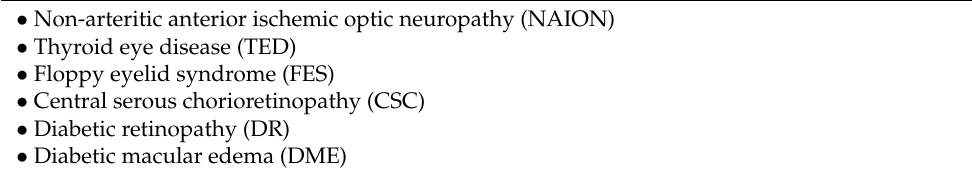
Table 2. Ocular complications that may benefit from CPAP